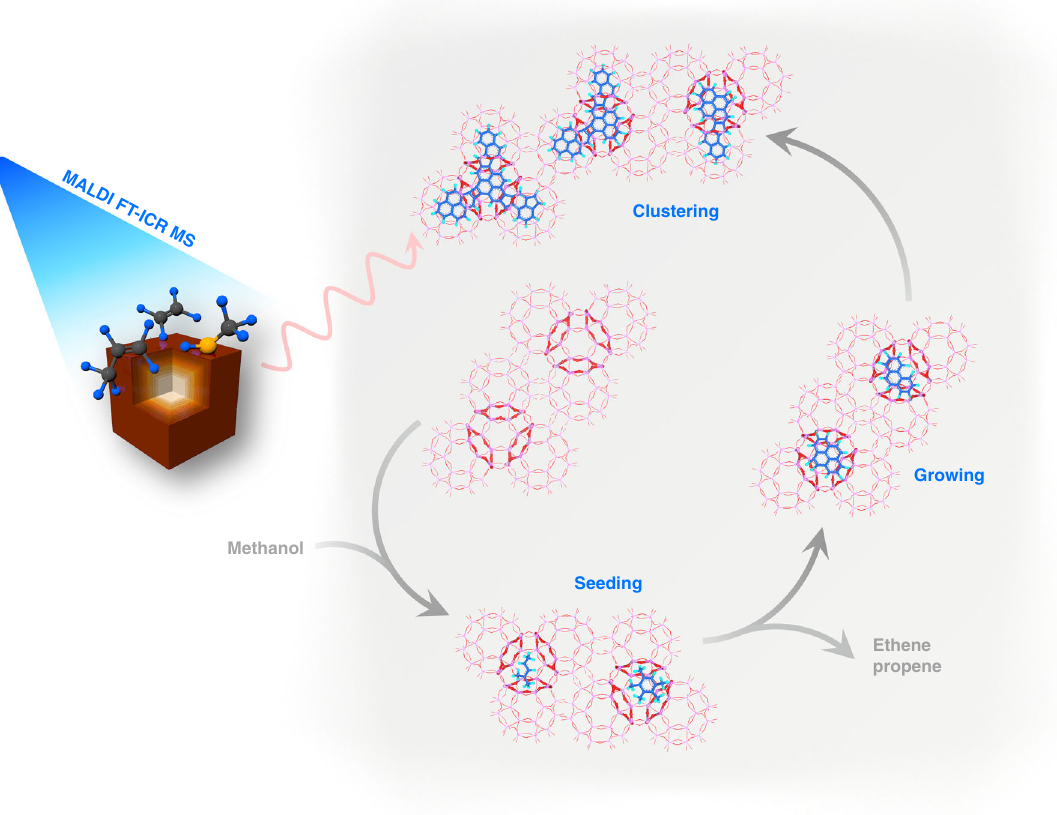
Fig. 5 Molecular evolution route of PAHs. PAHs evolve from occluded long chain ole fi ns and light polymethylbenzenes (coined “ seeding ” ) to three- four- ring PAHs behaving as building units for aromatic cluster formation ( “ growing ” ), and eventually to cage-passing aromatic clusters ( “ clustering ”